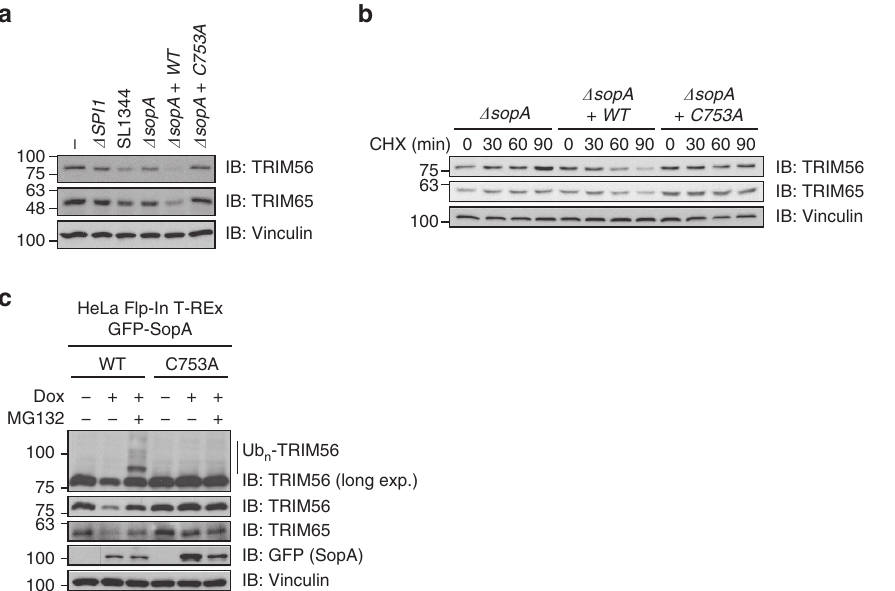
Figure 7 | Salmonella infection induces proteasomal degradation of TRIM56 and TRIM65. ( a ) TRIM56 and TRIM65 protein levels decrease in SopA activity-dependent manner. Lysates from HCT116 cells infected with Salmonella SL1344 WT, D SPI1 or indicated sopA mutant strains were subjected to SDS– PAGE and immunoblotting. ( b ) SopA-mediated degradation of TRIM56 and TRIM65 on infection. Lysates from HCT116 cells treated with 100 m gml (cid:3) 1 cycloheximide and infected with the indicated sopA mutant Salmonella strains for indicated time points were subjected to SDS–PAGE and immunoblotting. ( c ) SopA-mediated degradation of TRIM56 and TRIM65 on heterologous expression. Lysates from inducible HeLa Flp-In T-REx GFP-SopA cells left untreated or treated with indicated combinations of 1 m gml (cid:3) 1 doxycycline and 20 m M MG132 were subjected to SDS–PAGE and immunoblotting.